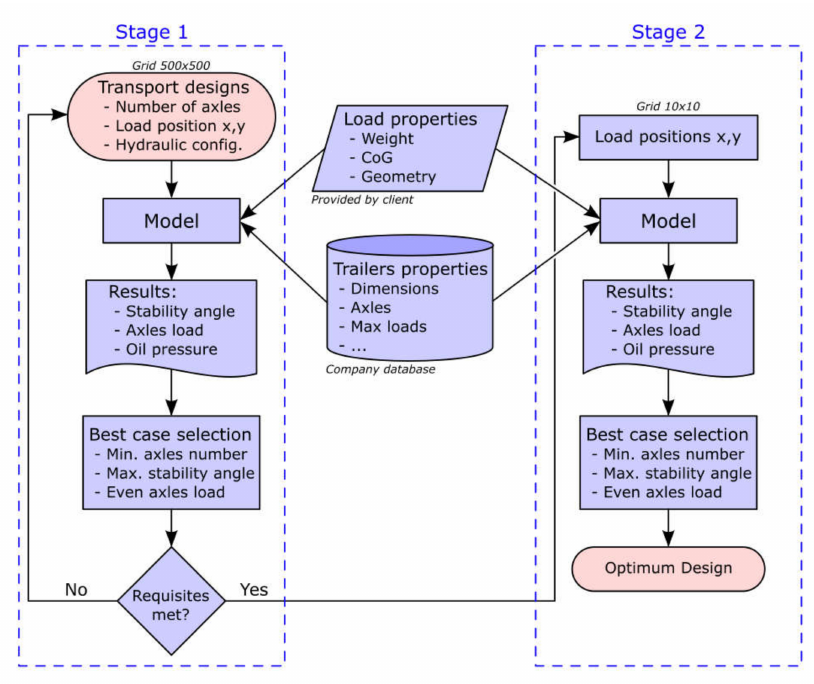
Figure 9. Flowchart of the optimization